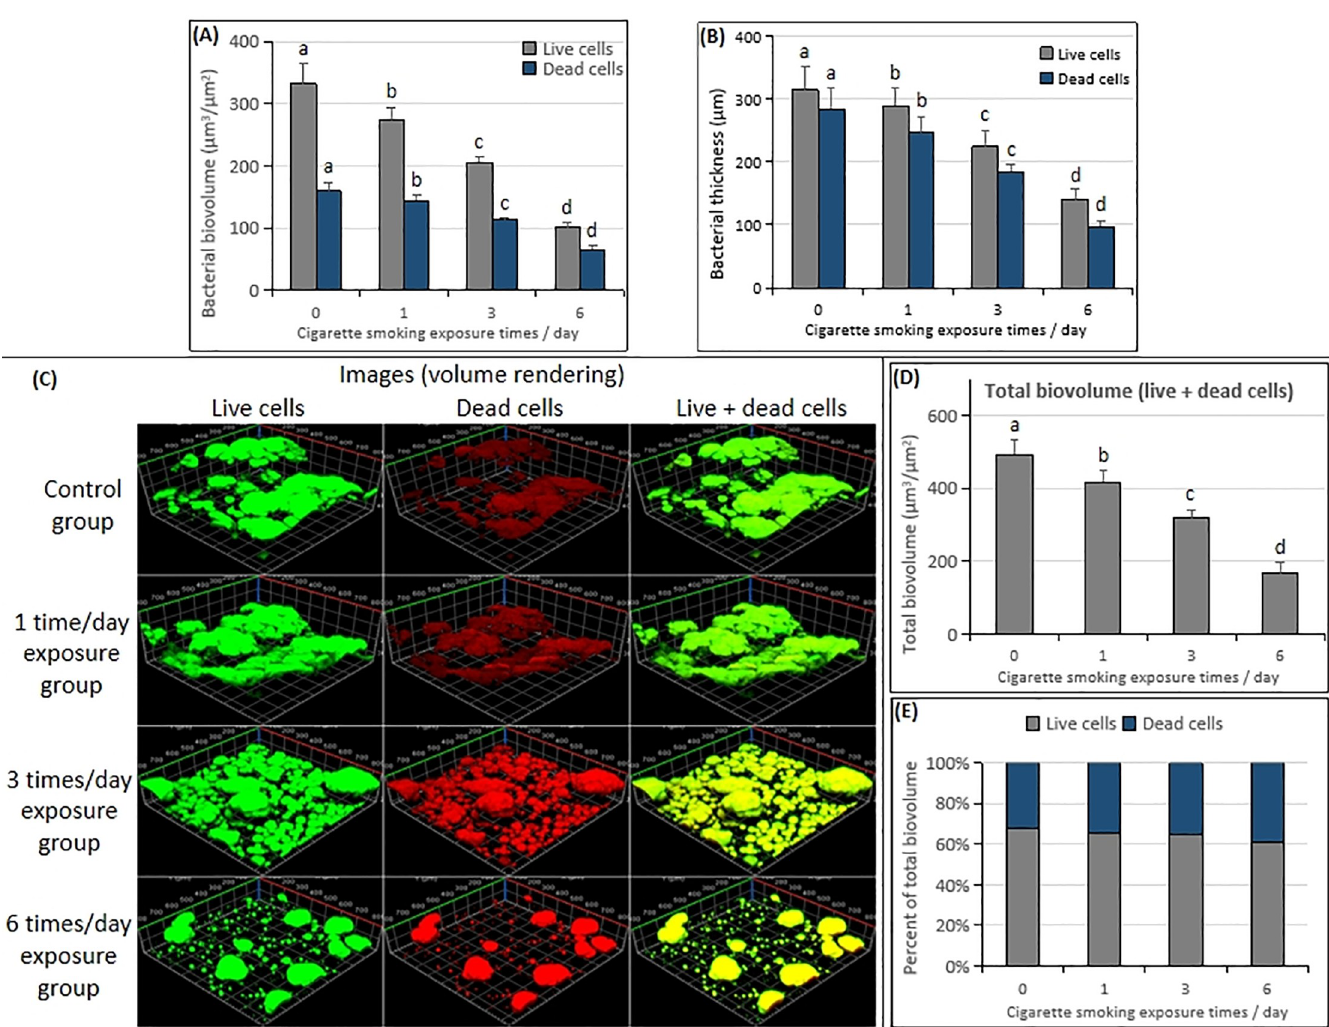
Fig 5. Change in CLSM of bacterial cells in the 74-h-old S . mutans UA159 biofilms exposure with CS. ( A ) Bacterial biovolume. ( B ) Bacterial thickness. ( C ) Representative confocal images. ( D ) Total biovolume (live + dead cells). ( E ) Percent of the total biovolume. Significantly different from each other ( p < 0.05).